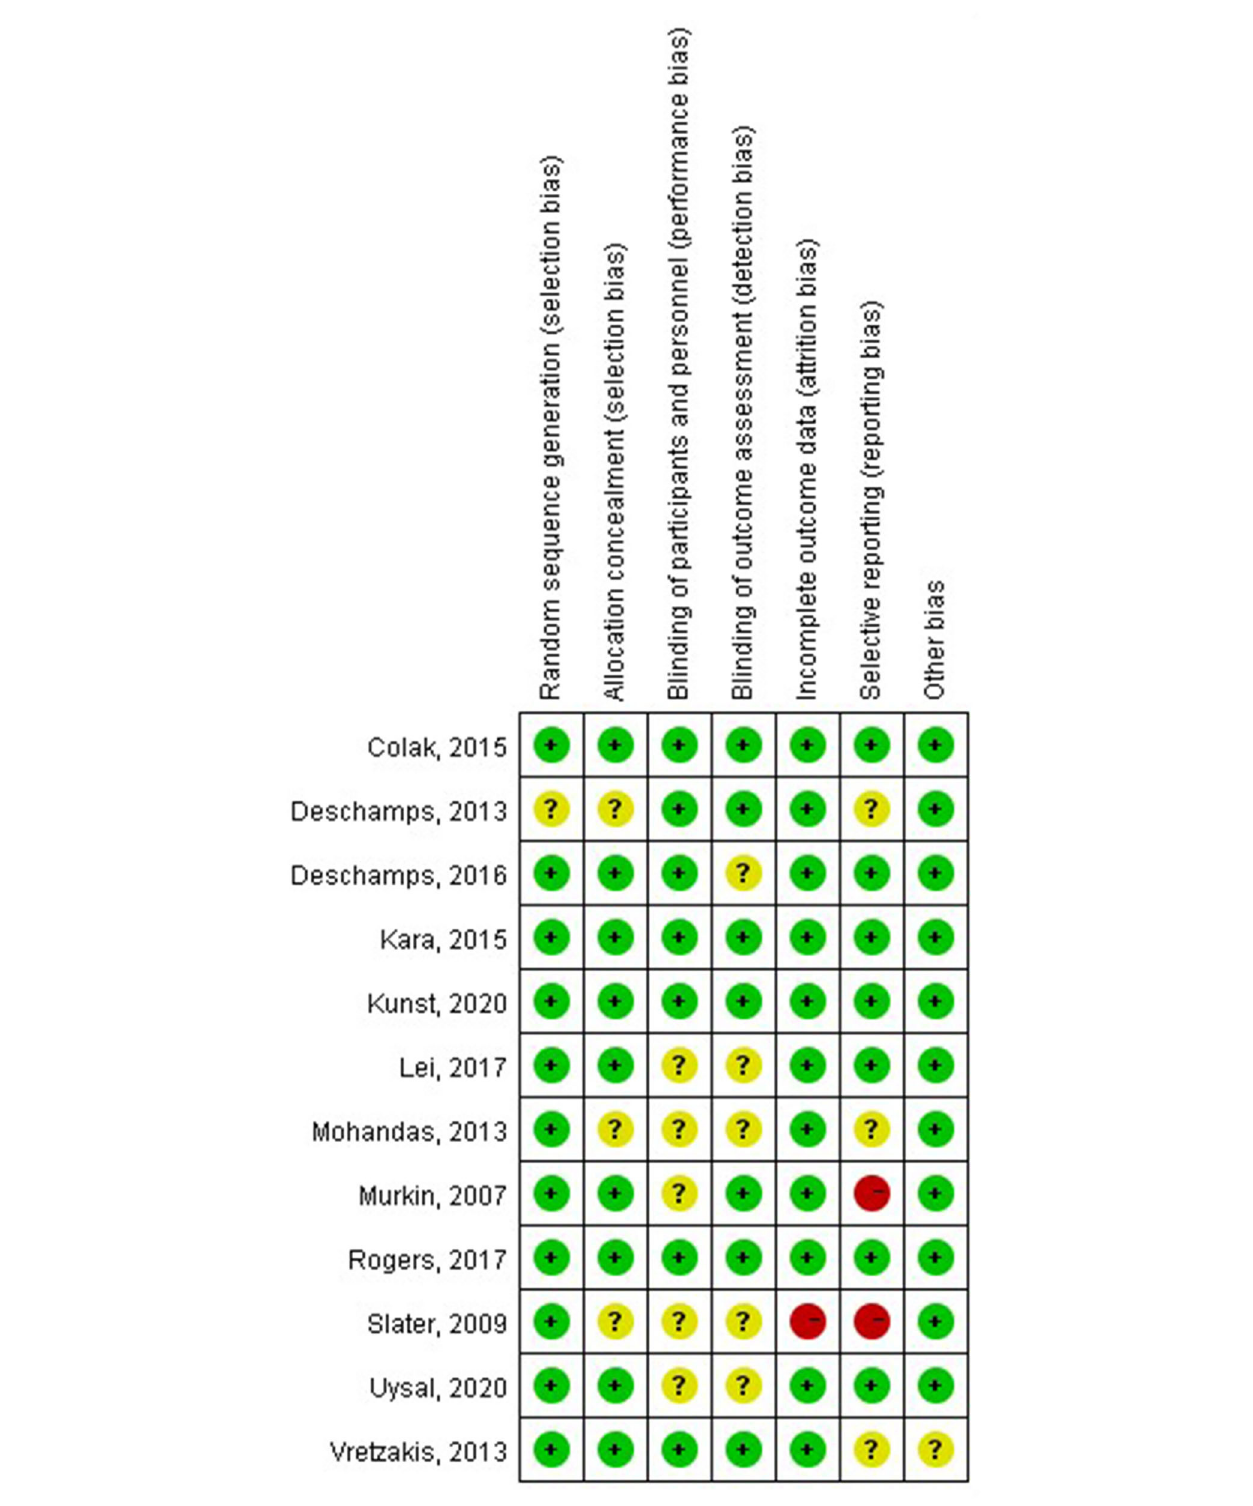
Frontiers in Cardiovascular Medicine |